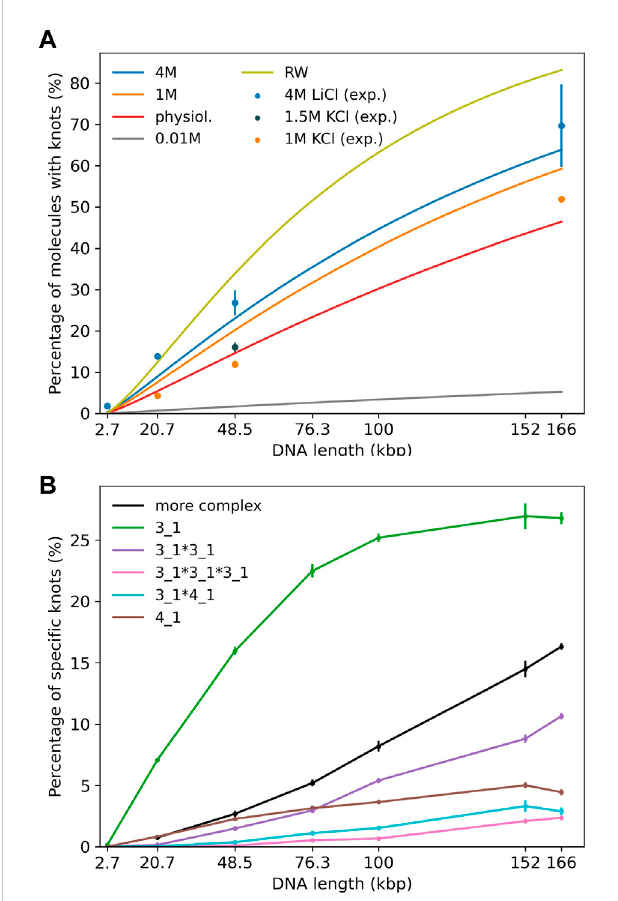
FIGURE 2 (A) KnottingprobabilityasafunctionofchainlengthforDNAchains of up to 166 kbp in comparison to recent experiments (Plesa et al., 2016; Kumar Sharma et al., 2019). Straight lines refer to simulations and data points to experiments. Different colors represent varying ionic conditions. (B) Knot spectrum as a function of DNA length for simulations in a high salt solvent (4 M) scenario. Complex knots refer to all other knots not listed here excluding the